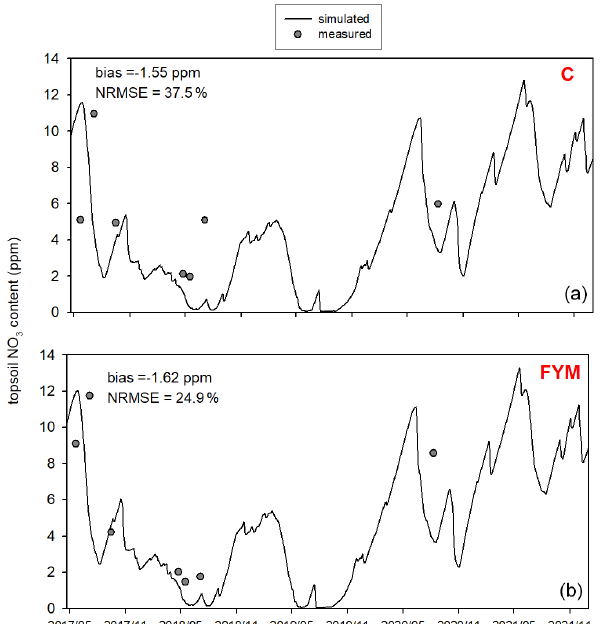
Figure 11. Comparison of the simulated and observed NO 3 con- tent of the topsoil for the absolute control ( C; a) and for the farm- yard manure ( FYM; b) treatment between May 2017 and November 2021 at Martonvásár.